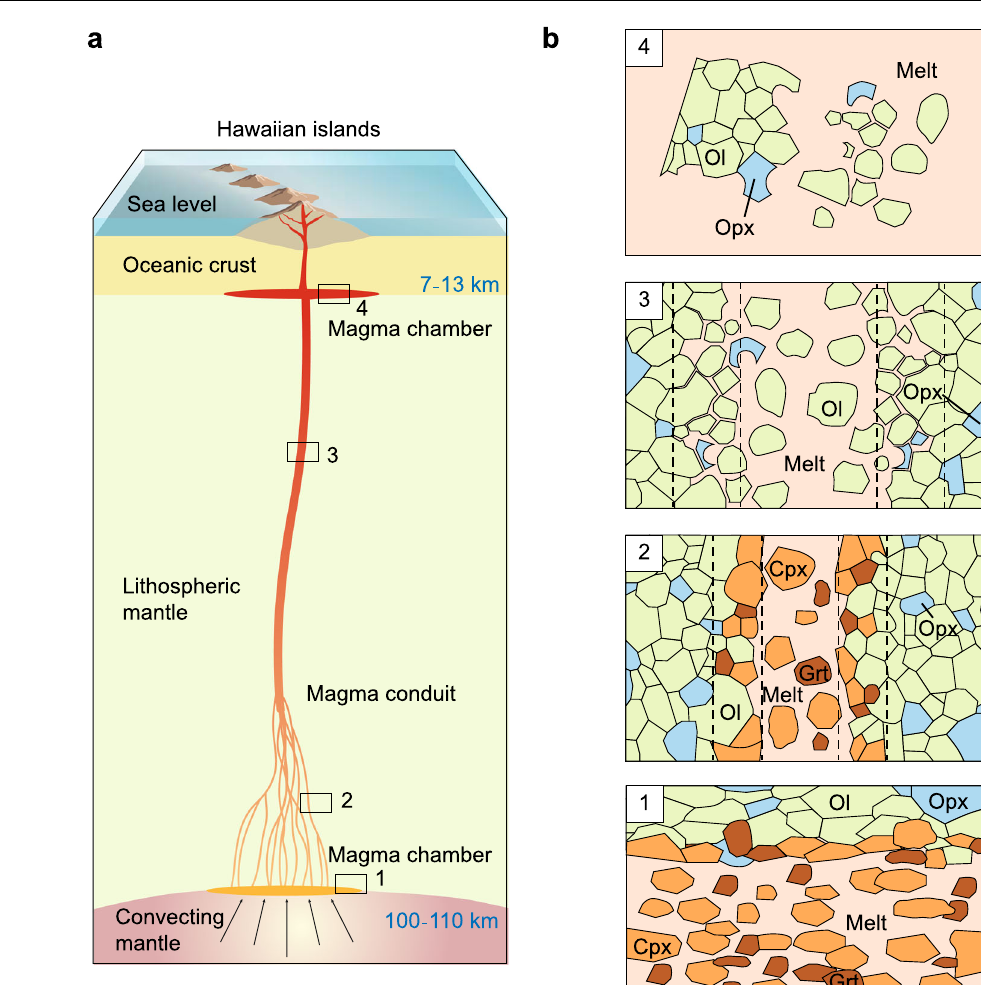
clinopyroxene, and garnet is formed between the magma and the surrounding lithospheric harzburgite, isolating them from further reaction. In the shallower magmachannelsandcrustalchamber(3and4),magmaassimilatesorthopyroxene from the harzburgite, while olivine becomes the sole mineral saturated with the